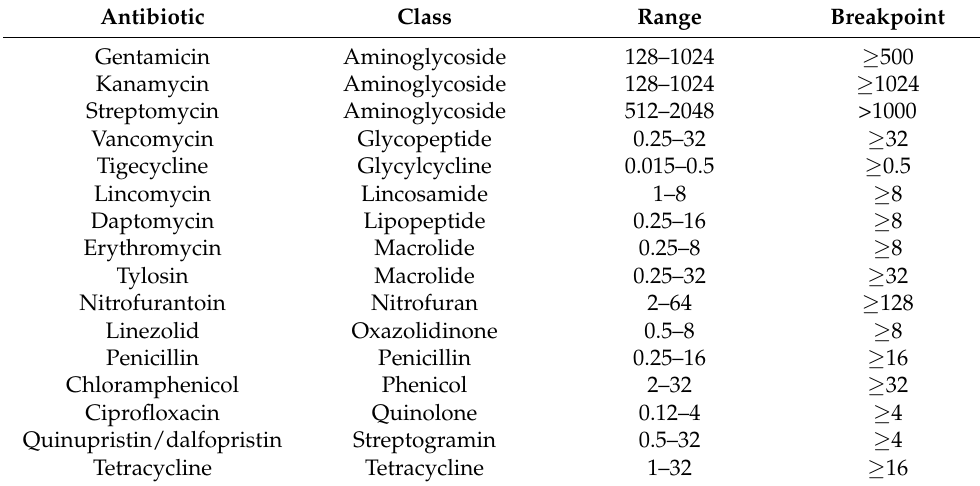
Table 1. Antibiotics ordered by class, concentration ranges (mg/L) and interpretive breakpoints (for resistance) for the NARMS (National Antimicrobial Resistance Monitoring System) Gram-positive plate (CMV3AGP), using CLSI (Clinical and Laboratory Standards Institute) criteria and NARMS interpretive human breakpoints when a CLSI equivalent was unavailable.